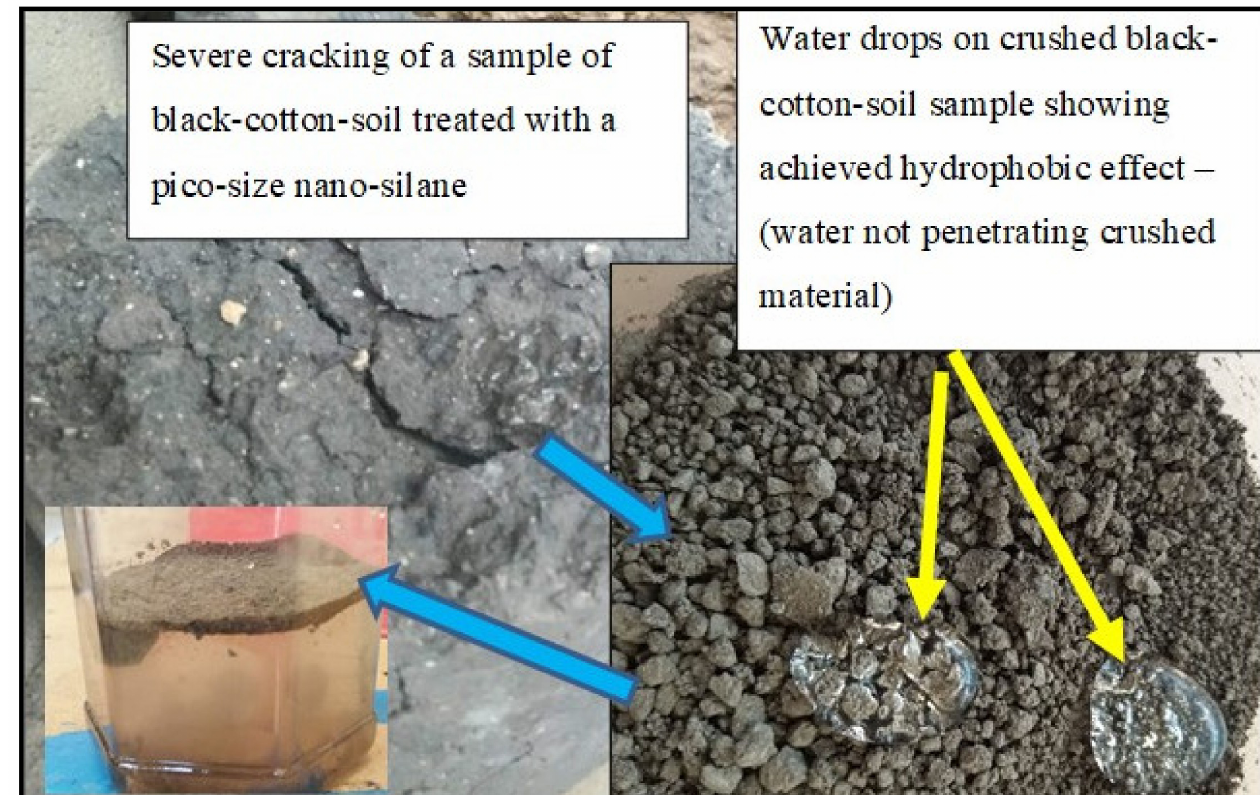
Figure 14. Treatment of black-cotton soil to obtain hydrophobicity with crushed clay particles floating on water (tests performed at GeoNANO Technologies, 2020—refer